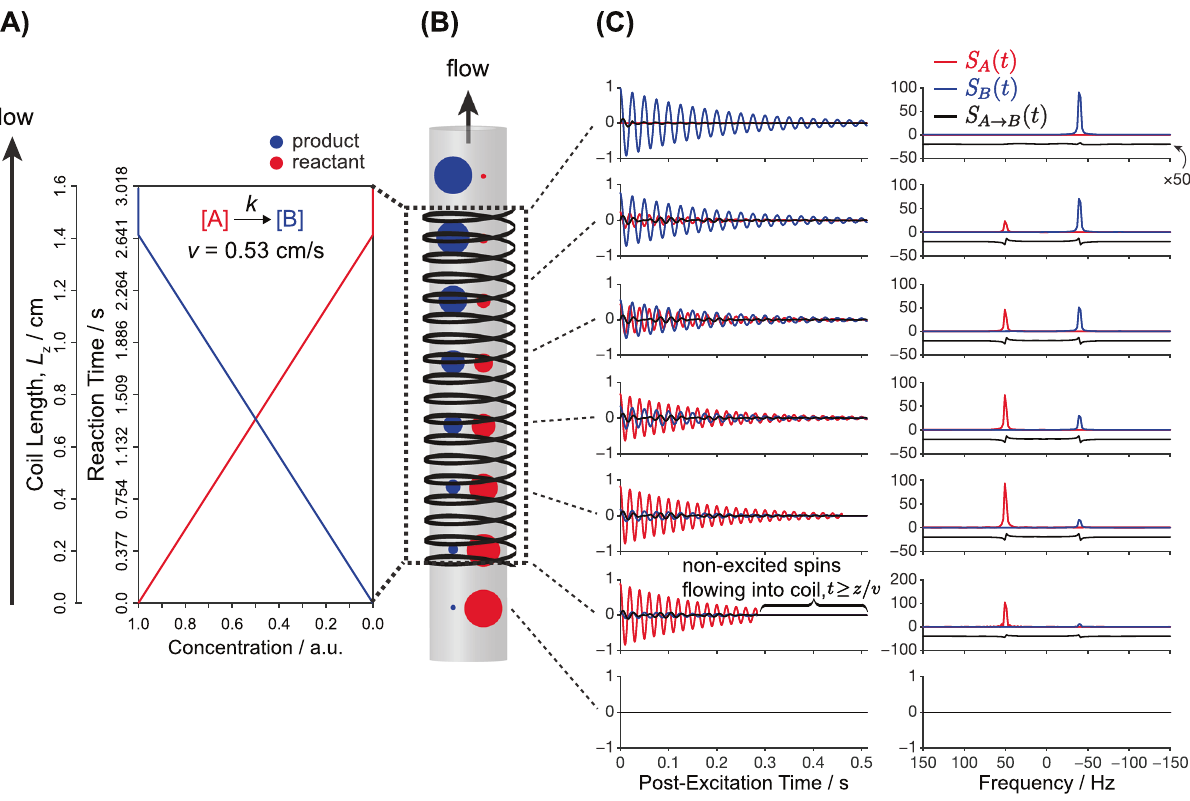
Fig. 5 Flow-based spatiotemporal encoding of chemical kinetics. A Zero-order kinetic pro fi le ( k = 0.375Ms − 1 ) assumed for an off-equilibrium reaction ( A → B ), plotted as a function of both reaction time and position for v = 0.53cm/s and L z = 1.6cm discretized over 256 unique z positions. B Schematic representation of the spatiotemporally-encoded chemical kinetics along the z spatial coordinate of the NMR coil that results from plug-like fl ow. The relative spatially-dependent concentrations of A and B are schematized with the red and blue circles, respectively, with their corresponding simulated time-resolved 1D NMR FIDs and spectra shown in C , which were generated using Eqs. (5, 6) of the main text. Notice the different scaling factors of the colored and black